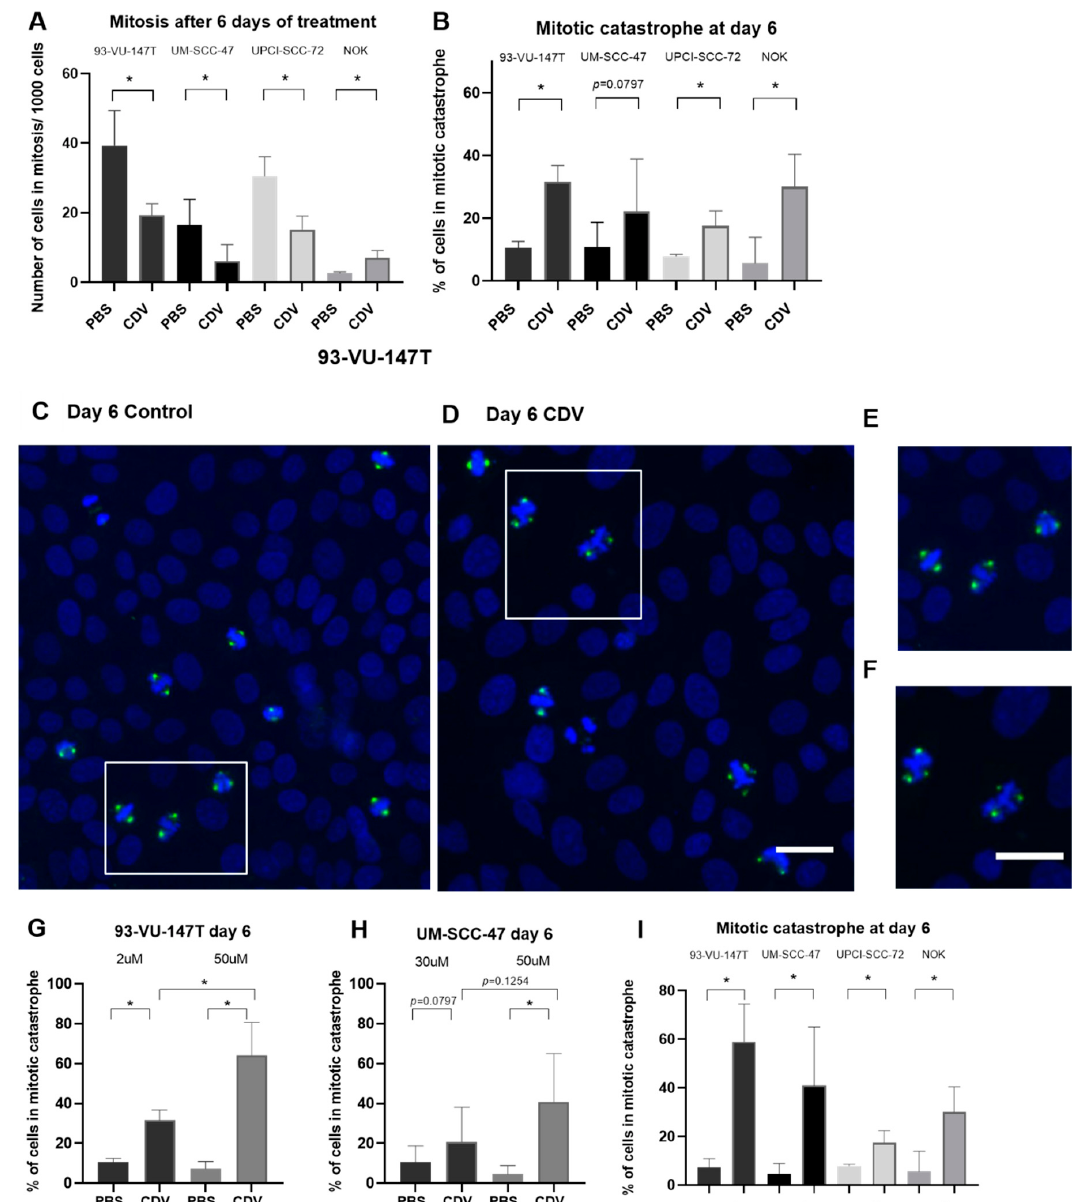
Figure 7. Induction of mitosis and mitotic catastrophe after treatment with CDV. The cells were treated with CDV or PBS for 3 and 6 days after which immunostaining of phospho-Aurora Kinase was performed. The cells were treated with an equal toxicity (IC 50 ) and with the same CDV concentration (50 µM). ( A ) The number of cells in mitosis (2 centrosomes) per 1000 counted cells and ( B ) percentage of cells in mitosis undergoing mitotic catastrophe when treated with PBS or CDV (IC 50 ). ( C ) Representative nuclei of 93-VU-147T untreated and ( D ) treated with CDV for 6 days. ( E ) Magnification of a normal mitotic figures and ( F ) 2 nuclei in mitotic catastrophe with multiple spindles visible ( G ) 93-VU-147T and ( H ) UM-SCC-47 cell line treated with IC 50 vs. 50 µM. ( I ) Percentage of control and treated cells in mitotic catastrophe when treated with 50 µM. Statistical significance was indicated as follows: p < 0.05 (*). The experiments were performed in triplicate. Scale bar of ( C – F ): 50 µm.